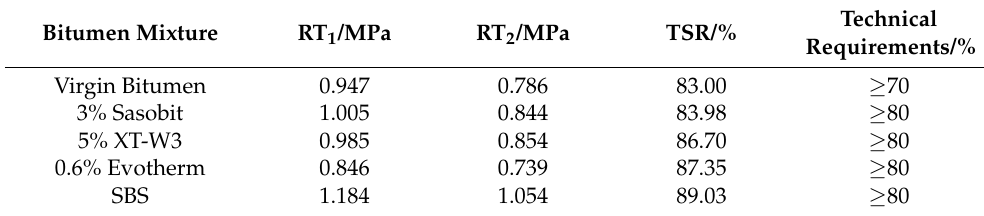
Table 9. Results of the freeze-thaw splitting